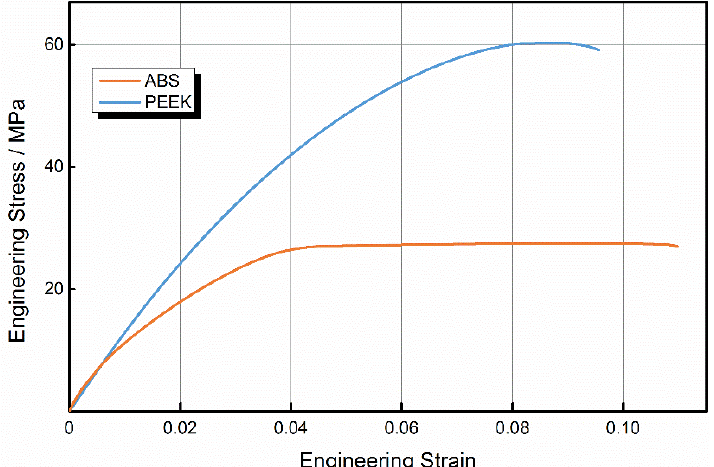
Figure 4. Tensile stress-strain curves of acrylonitrile butadiene styrene (ABS) and polyether-ether-ketone (PEEK).